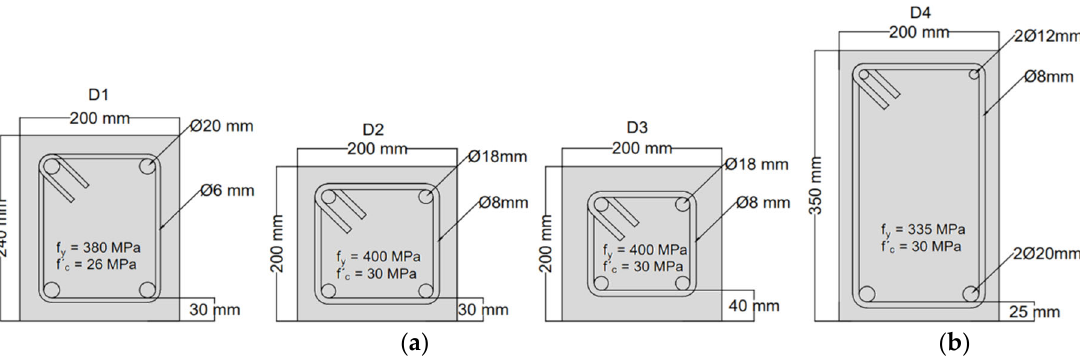
Figure 8. Structural sections of specimens tested: ( a ) Sections tested in flexo ‐ compression [30,37]; ( b ) section tested in bending moment [23].